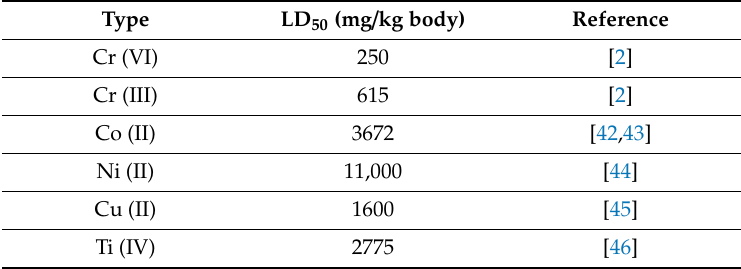
Table 5. Lethal dose of inorganic